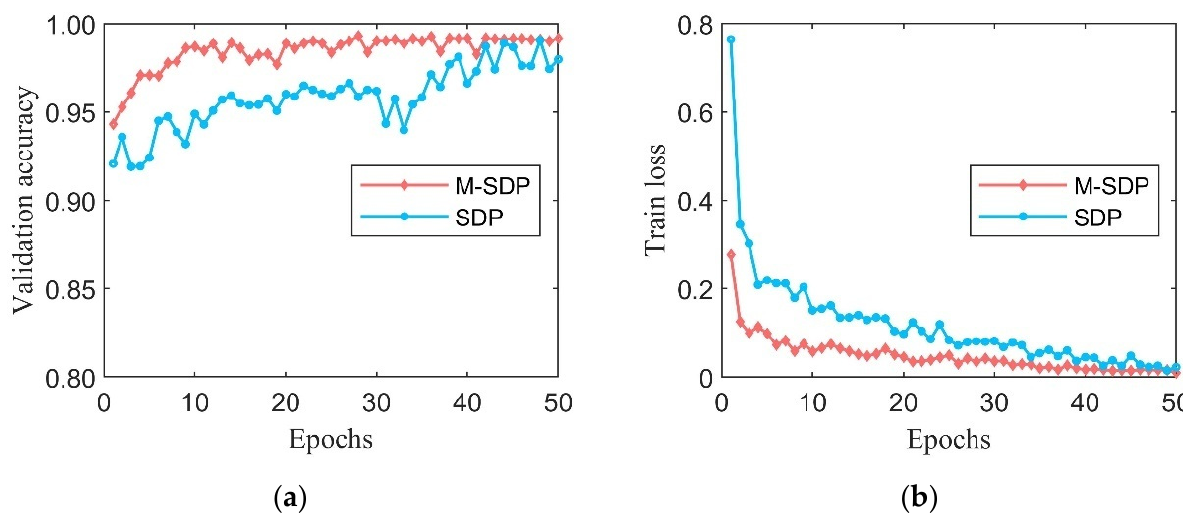
Figure 21. The training process using M-SDP and SDP: (a) validation accuracy curves; (b) training loss curves.